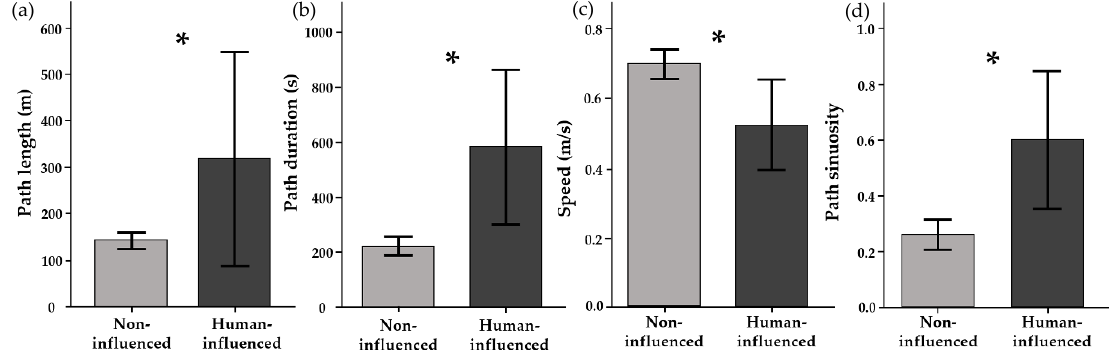
Figure 4. Comparison between the mean ( ± SE) ( a ) path length, ( b ) duration, ( c ) speed, and ( d ) sinuosity for stingray movement paths non-influenced ( n = 93) and those influenced by humans ( n = 5). Significant differences ( p < 0.05) in Mann–Whitney–Wilcoxon tests are denoted by *.